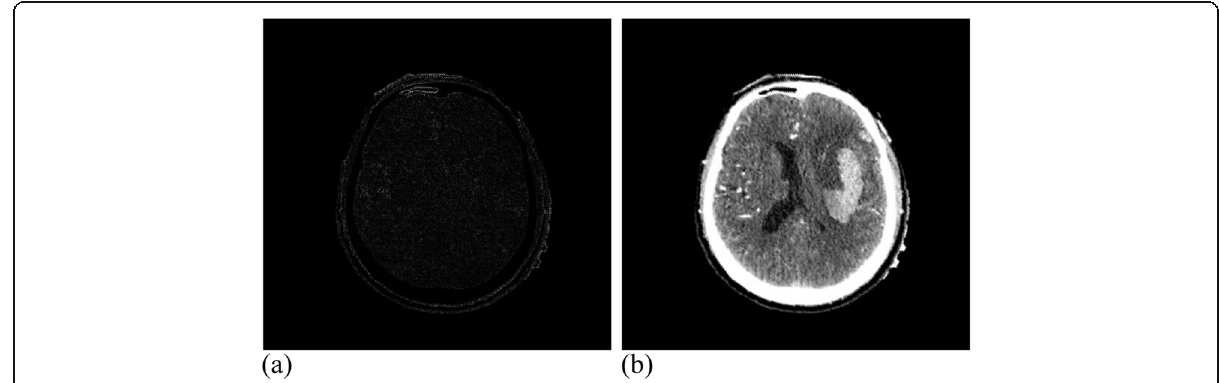
Fig. 9 CT data after registration. ( a ): Difference between CT reference image and registration image; ( b ): CT registration image